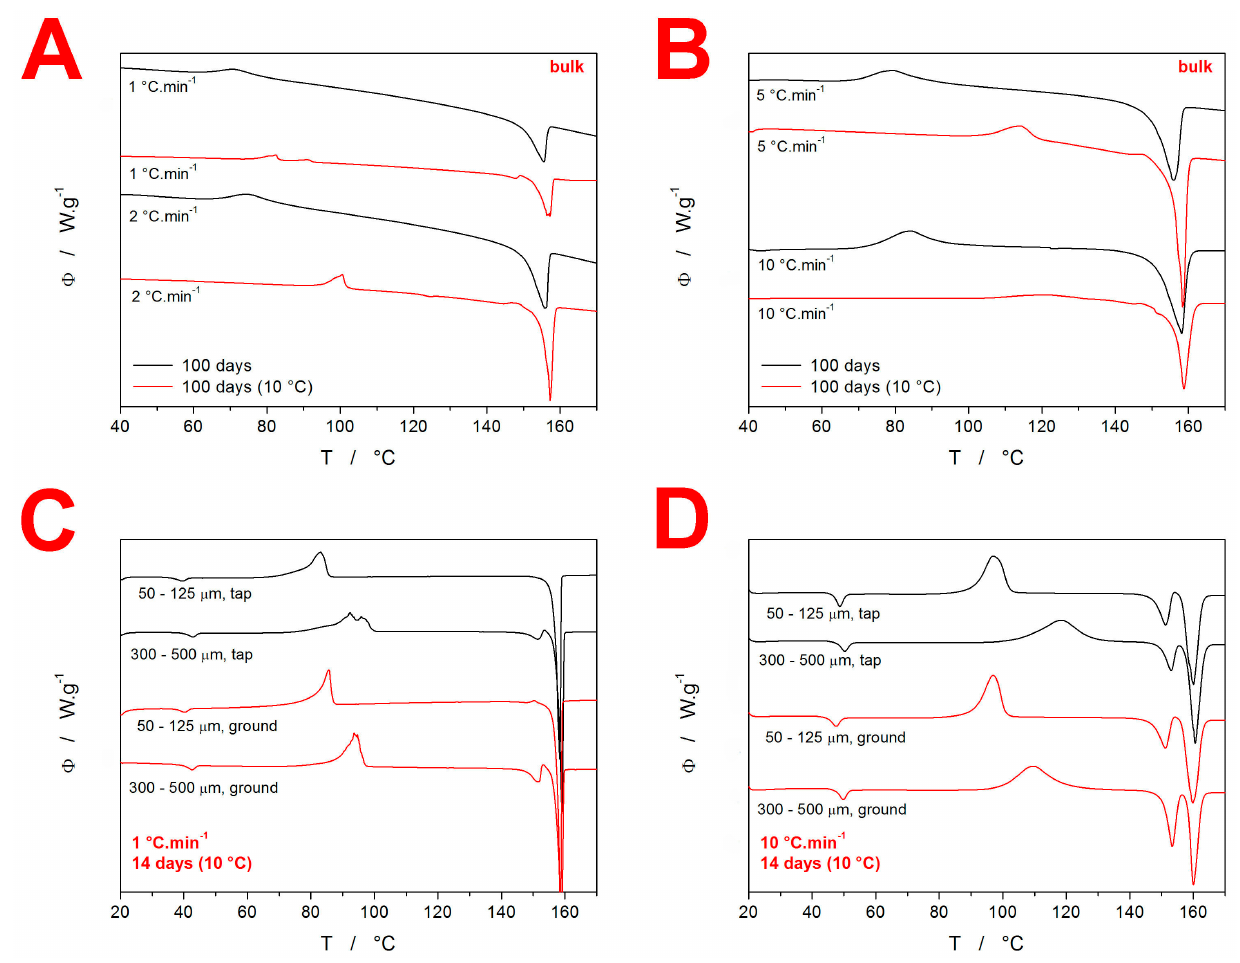
Figure 3. ( A , B ) Comparison of the DSC curves for the bulk IMC samples stored at either the laboratory temperature or at 10 ◦ C. Exothermic signals evolve in the upwards direction. ( C , D ) Comparison of selected DSC curves for the IMC powders stored for 14 days at 10 ◦ C and prepared either by gentle tapping or by forced grinding.